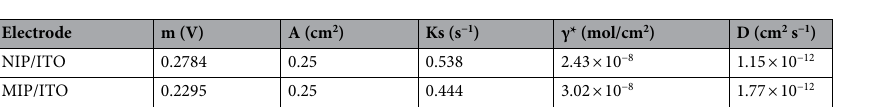
Table 4. Electrochemical parameters of NIP/ITO and MIP/ITO electrodes. The movement of electrons is very crucial in electrochemistry which was examined and analyzed by the measurement of kinetic interface factors such as the surface concentration of the redox probe of the electrode (I * ), diffusion constant (D), surface area (A e ) and electron transfer rate constant (K s ) for both NIP/ITO as well as MIP/ITO electrode.